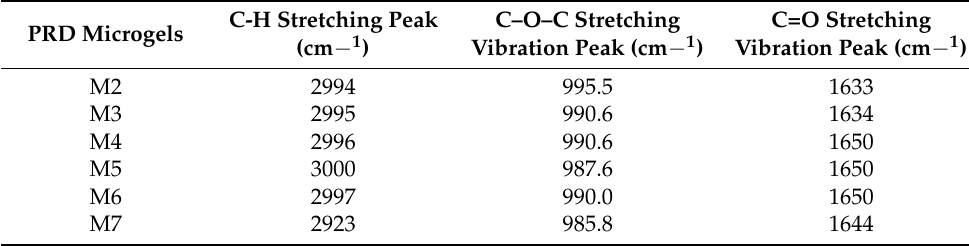
Table 6. The changes observed in the FTIR spectra of M 2-7 microgels.